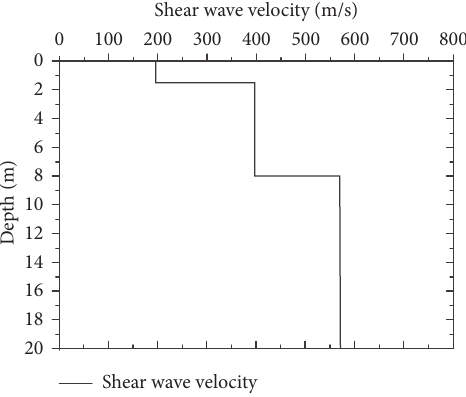
Figure 3: Shear wave velocity